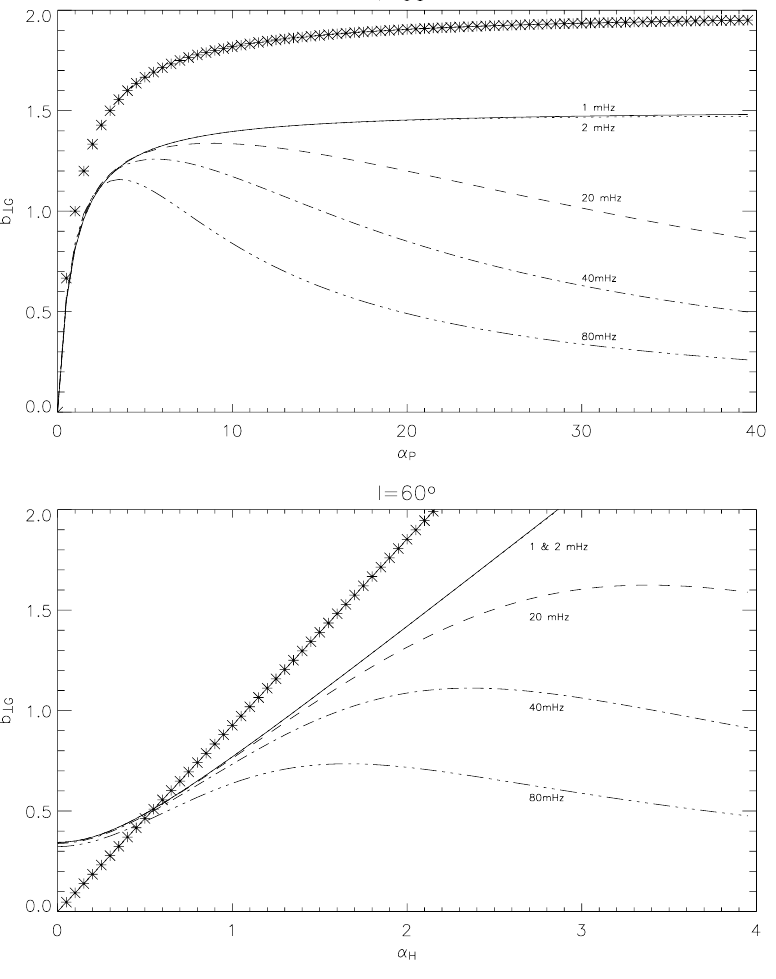
Fig. 4. The normalised, horizontal ULF magnetic field at the ground for a B 0 dip angle of 60 ◦ , V a = 1 × 10 6 ms − 1 , k x = 0, k y =1/d and d=100km. (a) Variation with α P for α H =2. (b) Variation with α H for 6 P = 10S. The * symbols show the 6 H